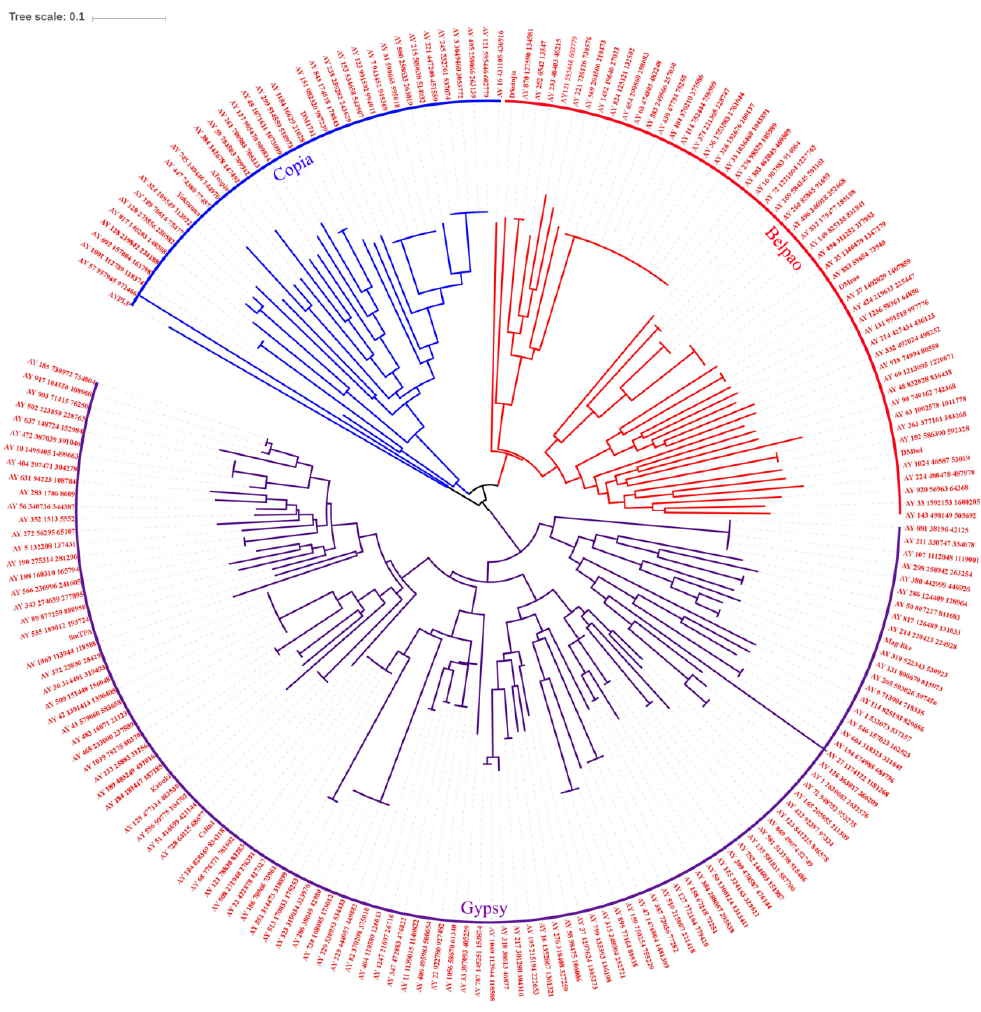
Figure 1. Phylogenetic tree of full-length AyLTRs based on the alignment of the RT region . A total of 189 AyLTRs contained an RT domain with su ffi cient conservation for confident alignment prior to phylogenetic analysis. Other reference LTRs belonging to Copia , Belpao and Gypsy that were used in